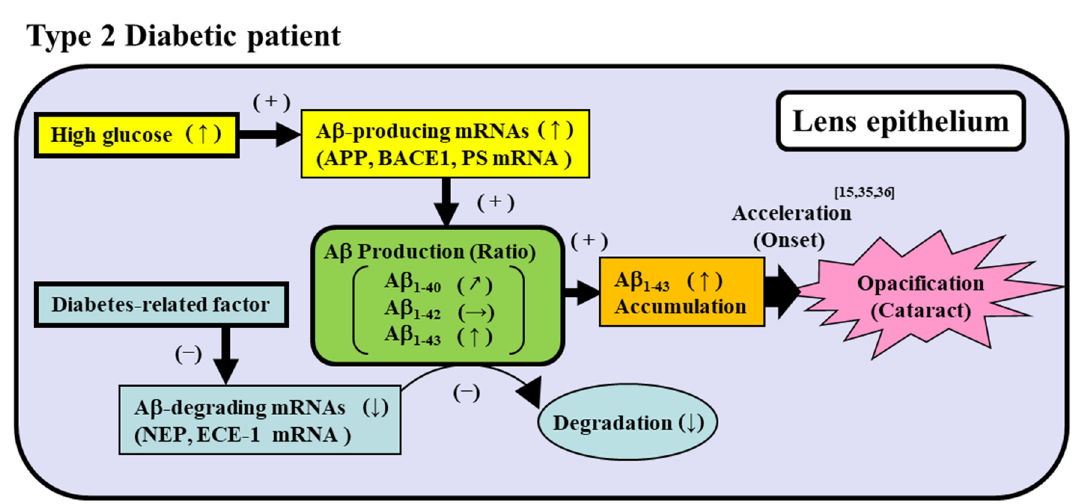
Scheme 1. Relationship between A β 1–43 accumulation and lens opacification in diabetic patients.